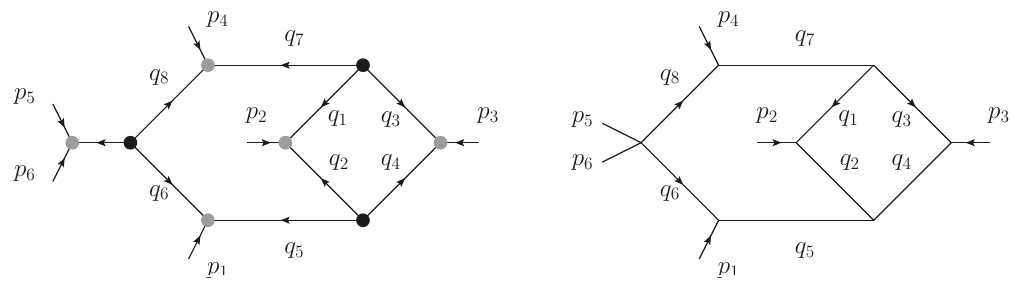
Figure 10 . Left: two-loop nonplanar six-leg supergraph of the MHV type. Right: the correspond- ing Feynman integral representing the bosonic function